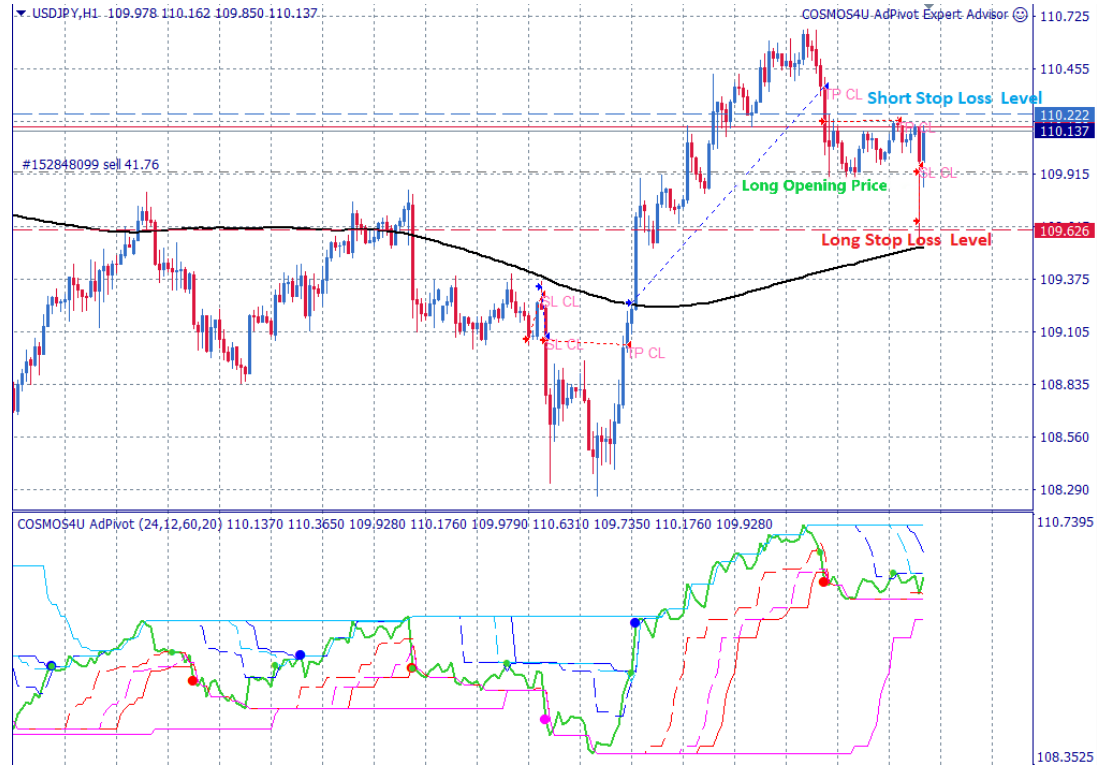
Figure 4. Long USDJPY and PIVOT indicator. Stop loss at ±